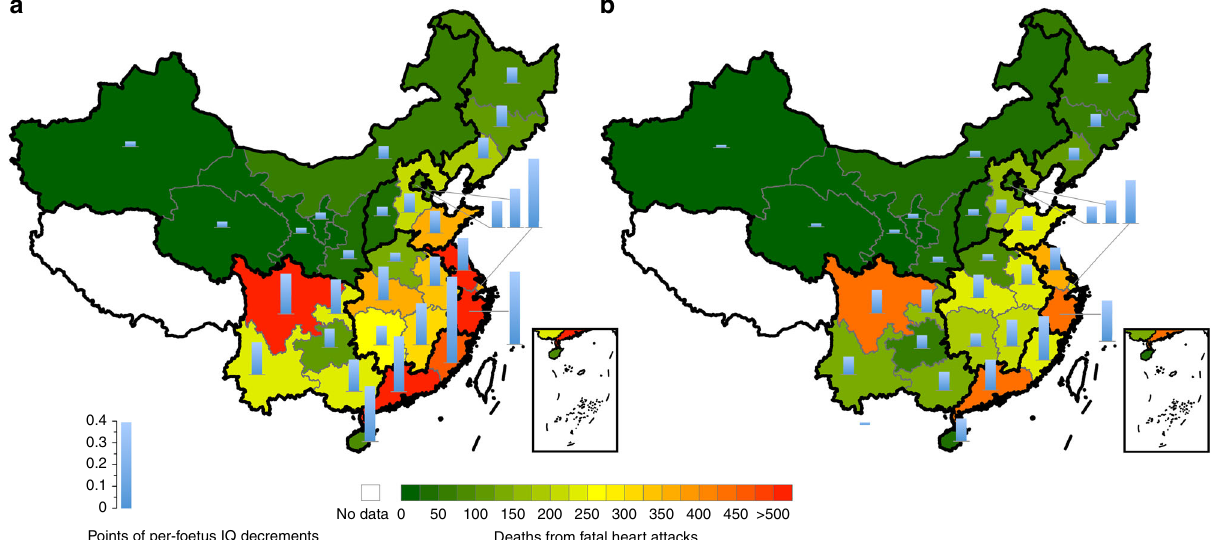
Fig. 1 Spatial distributions of per-foetus intelligence quotient (IQ) decrements and fatal heart attacks induced by the intake of methylmercury (MeHg) in China. a Total number induced by the intake of MeHg from all mercury (Hg) emission sources, and b the number induced by the intake of MeHg from Chinese anthropogenic Hg emissions. The coloured background represents the deaths from fatal heart attacks, and blue bars represent the points of